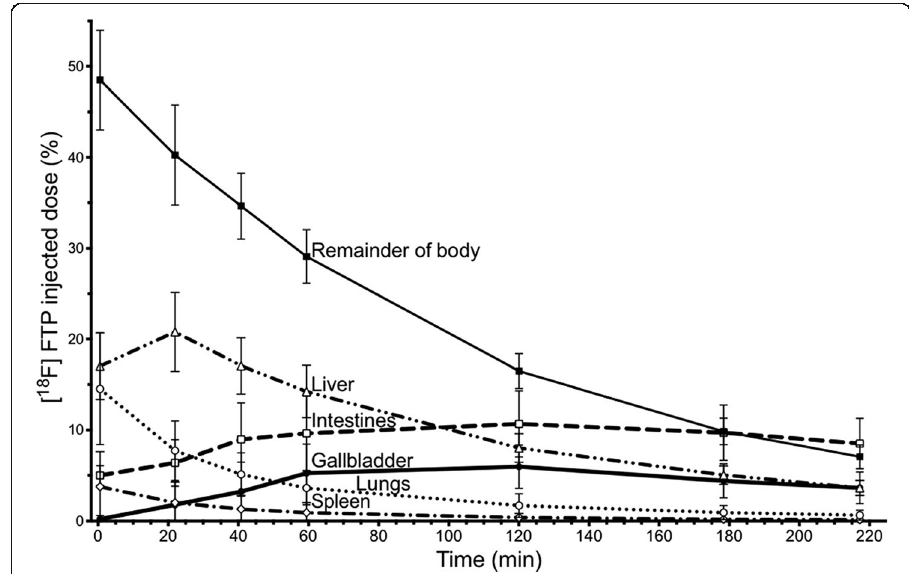
Fig. 2 FTP percent injected dose measures over time for the control